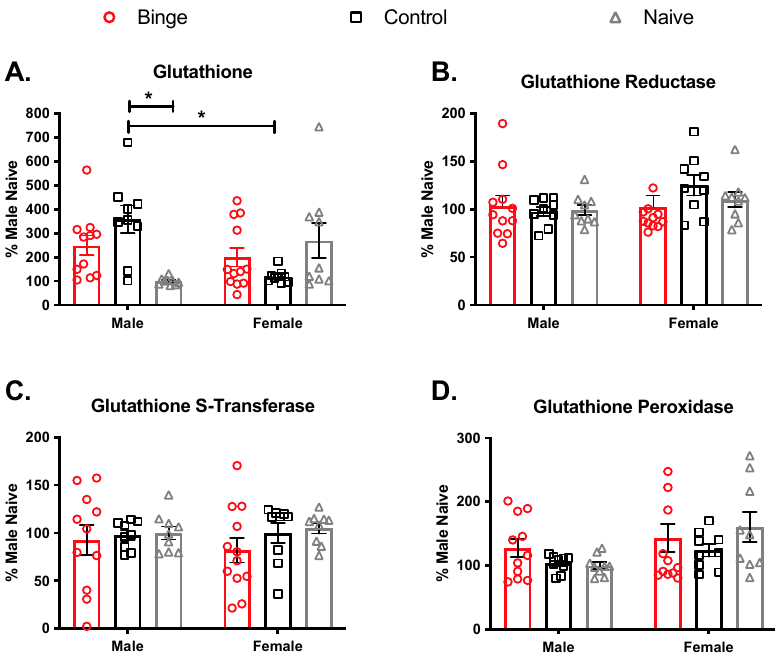
Figure 7. Effects of multiple binge on antioxidant capacity in the striatum. Gavage experience sig-